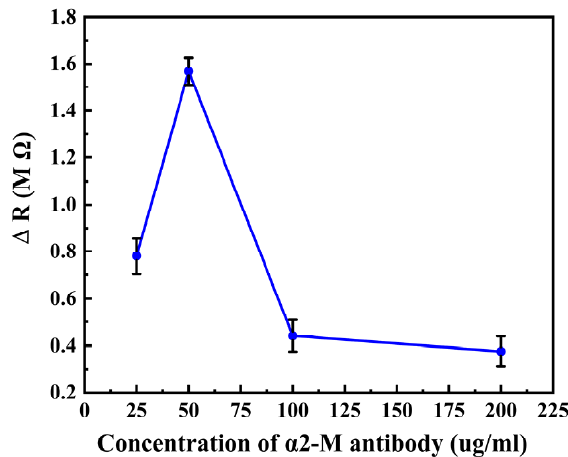
Figure 8. Δ R corresponding to different concentrations of α 2 ‐ M antibody. Figure 8. ∆ R corresponding to different concentrations of α 2-M